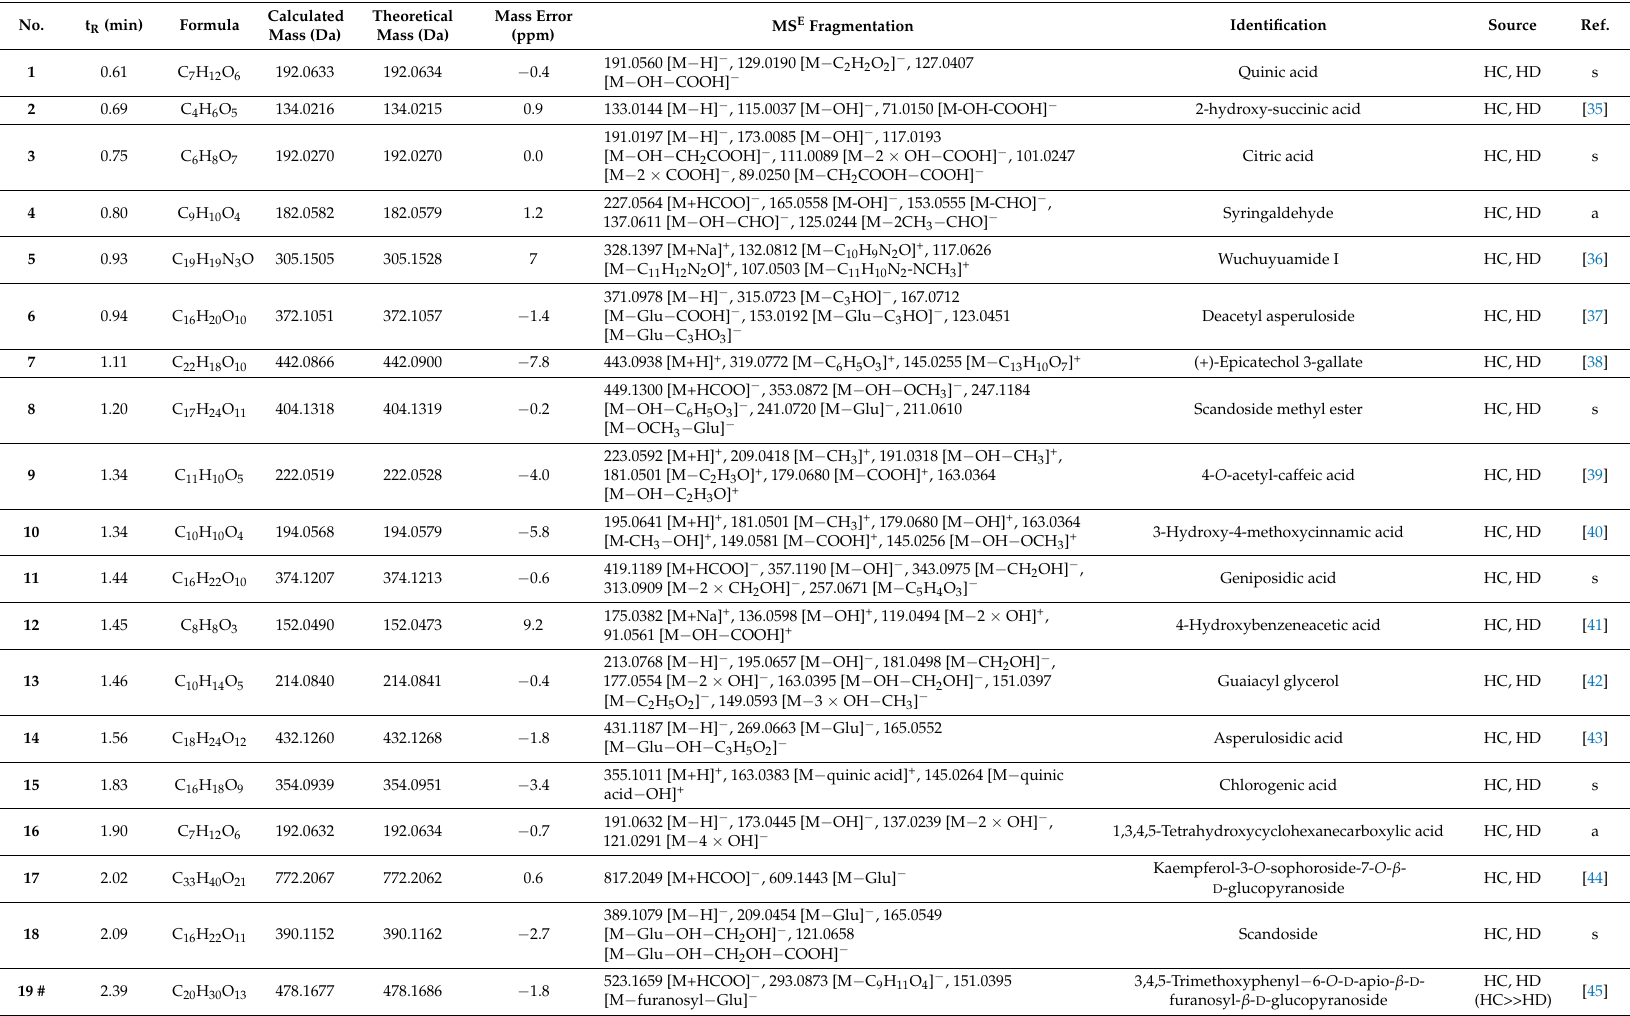
Table 2. Compounds identified from HD and HC by UPLC-QTOF-MS E